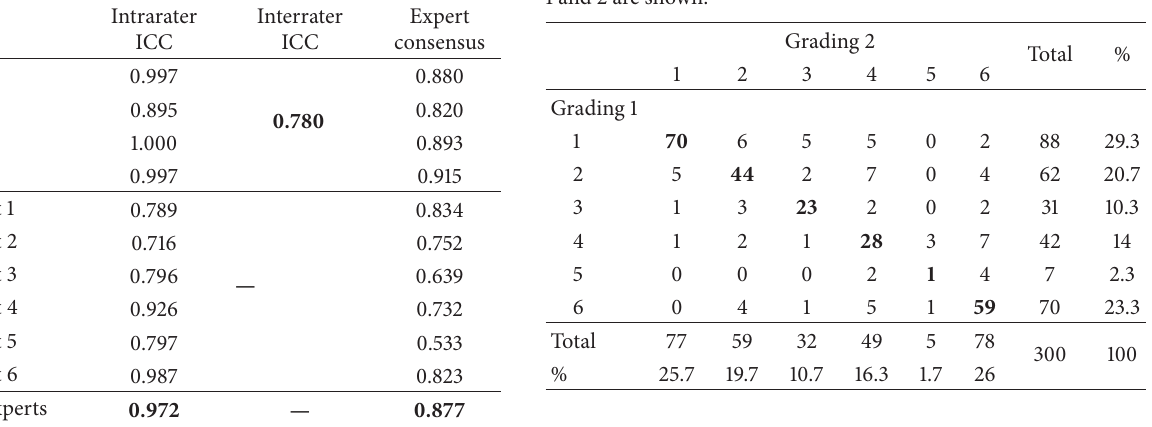
Table 2: Intra- and interrater test/retest reproducibility for expert and nonexpert observers assessed by calculation of intraclass corre- lation coefficients (ICC).